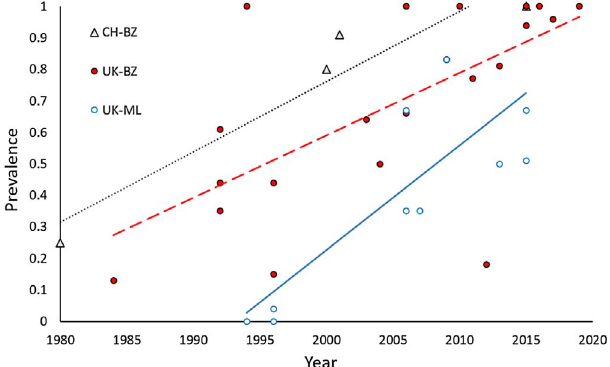
Figure 6. Change in the prevalence of anthelmintic resistance (= proportion of farms testing positive) for benzimidazoles (BZ) in Switzerland (CH; dotted black line) and the United Kingdom (UK; dashed red line), and macrocyclic lactones excluding moxidectin (MOX) in the United Kingdom (solid blue line). Only studies testing more than one farm were included. For regression equations, see Table S4(a – c). Data point for CH-BZ at (2016, 1) is partly